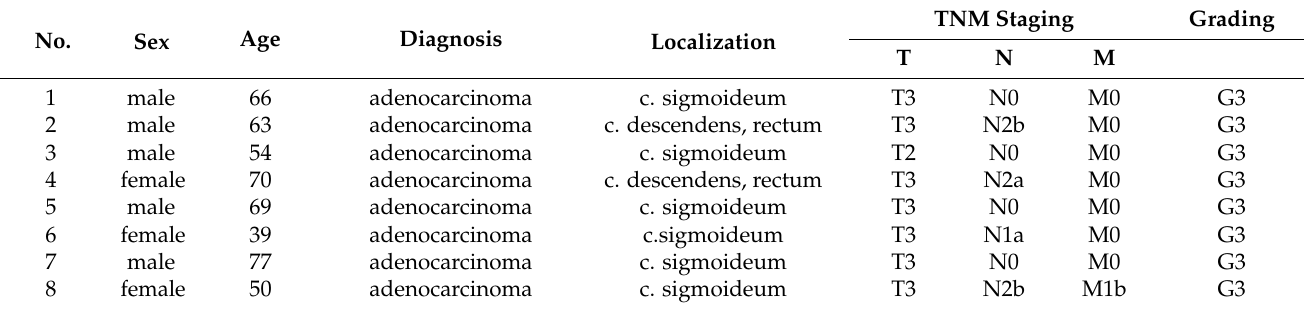
Table 1. Basic characteristics of patients used in this study.